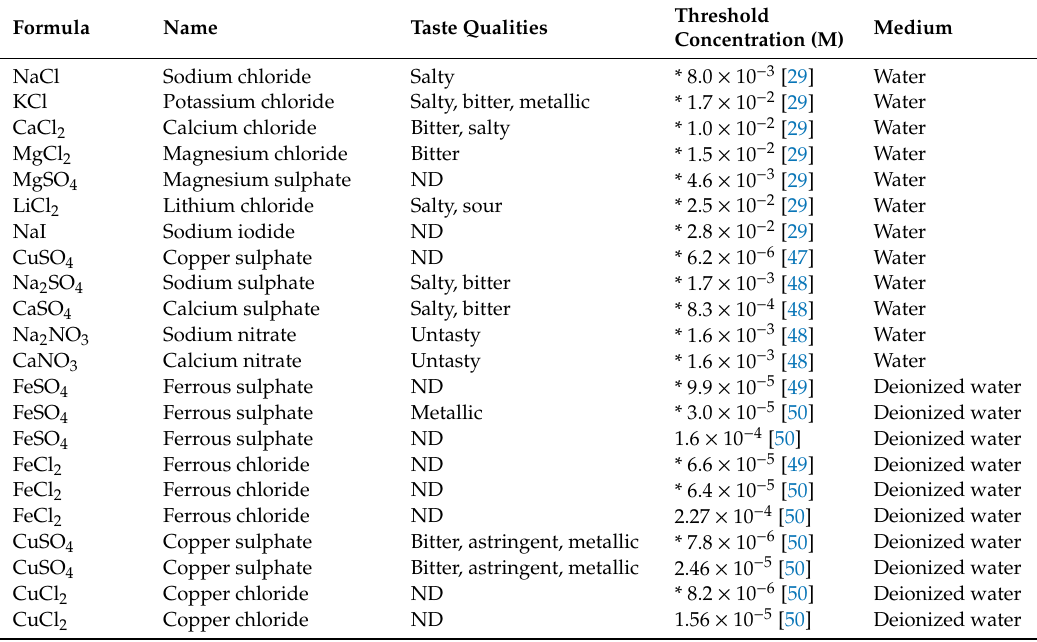
Table 4. Taste qualities and threshold concentration of mineral salts in di ff erent mediums, with or without nose-clip.